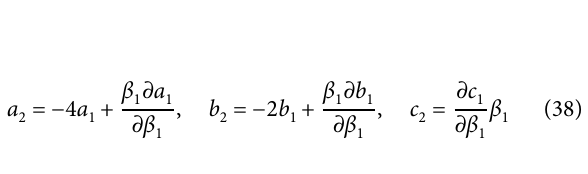
FIGURE 4 | Effects of different parameters on the limit point instability load of the pin-ended FGM arches: (A) Material type. (B) Modified geometric slenderness 𝜆 s . (C) Power-law index p . (D) Proportional coefficient of homogeneous ceramic layer α